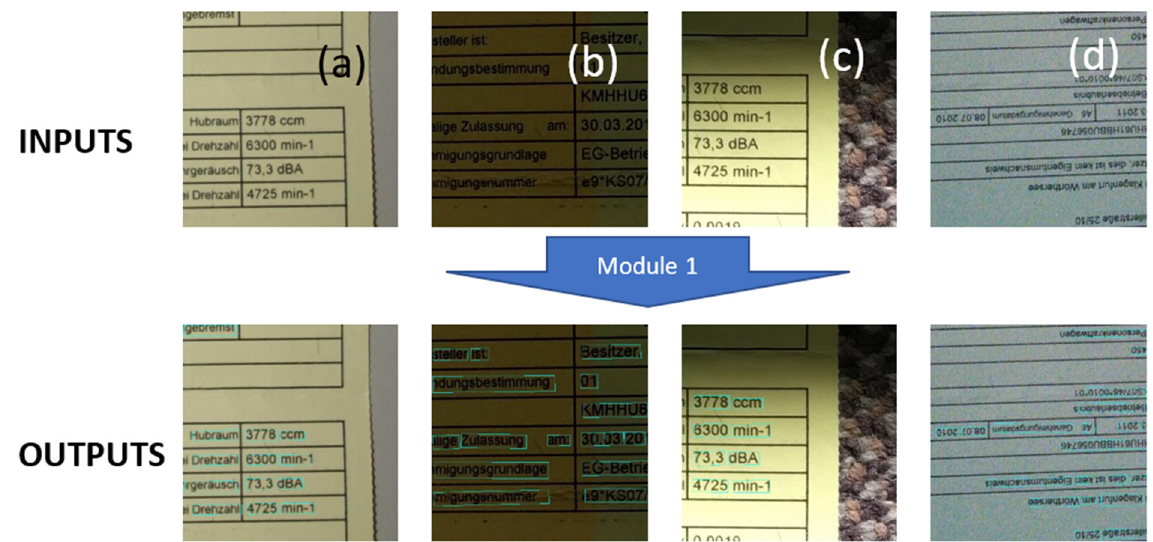
Figure 15. Samples of detected text bounding boxes obtained using our Module 1 as shown in Figure 5. The detected text boxes are marked with colored rectangles: ( a ) The text detection under normal conditions, i.e., very small or almost no distortion. ( b ) The text detection with contrast problems. ( c ) The text detection with shadow problems. ( d ) The text detection with noise and rotation problems. Table 1. The test results of a comprehensive benchmarking of our model (for text detection) against selected state-of-the-art